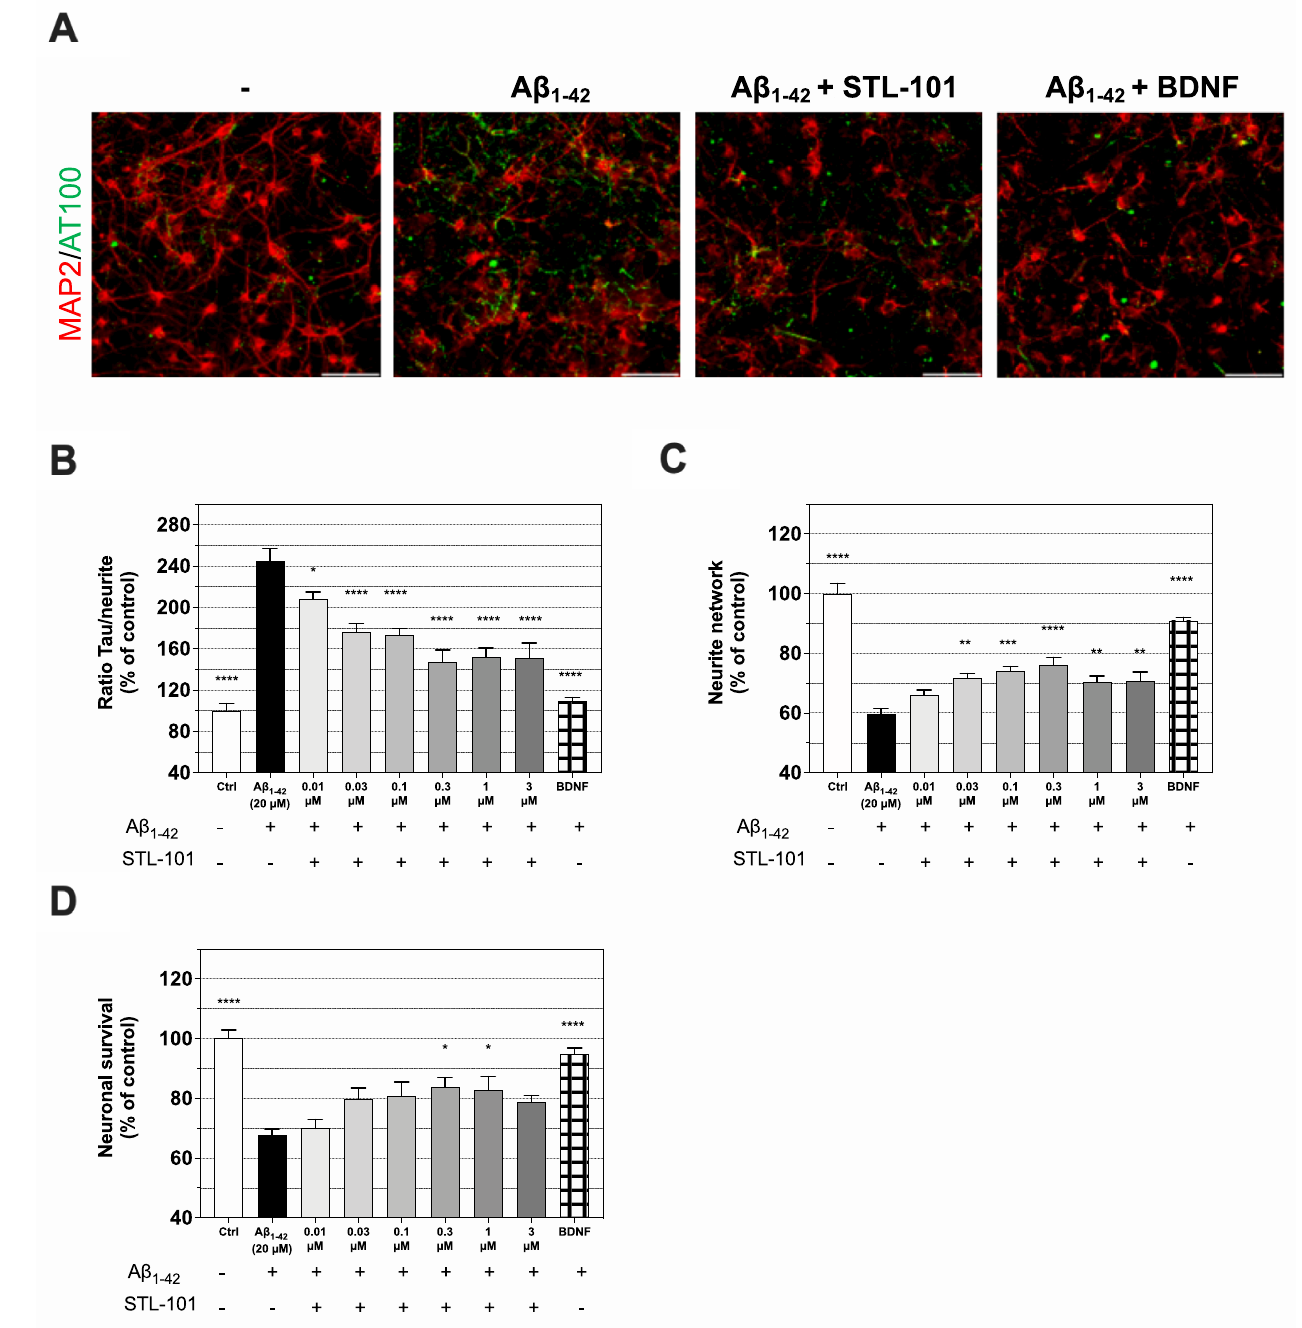
Fig 3. STL-101 protects against acute injury with A β 1–42 in rat cortical neurons. (A) Representative IF of MAP2 (red) and p-tau (AT100, green) in control (-), A β 1–42 injured neurons, A β 1–42 injured neurons pretreated with STL-101 at 0.3 μ Mfor 24h and A β 1–42 injured neurons treated with BDNF at 50ng/mL. A β 1–42 was used at 20 μ M.Scale bar = 100 μ m. (B) Quantification of p-tau in MAP2/AT100 IFs as shown in A. and with STL-101 pretreatment at the indicated concentrations. (C) Measurement of neurite network as shown in A. (D) Neuron survival quantification after A β 1–42 injury. STL-101 pretreatments were performed at the indicated concentrations and the neurotrophic factor BDNF was used as a positive control at 50ng/mL. Control (Ctrl) = culture medium with 0.1% DMSO. Results are expressed as a percentage of control condition and mean +/- SEM (n = 4–6 wells/condition) is shown. Statistical analysis was performed using one-way ANOVA followed by Dunnett’s multiple comparison test ( � p < 0.05, �� p < 0.01, ��� p < 0.001, ���� p < 0.0001in comparison with A β 1–42 ).